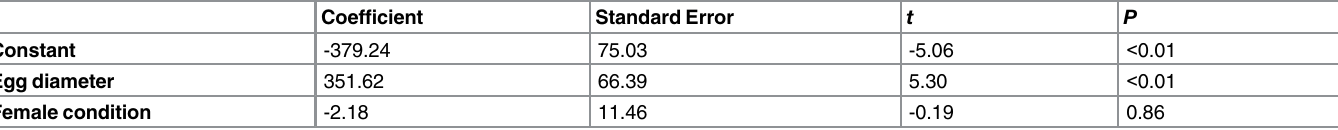
Table 3. Multiple linear regression analysis of the effect of egg diameter and female condition on survival in the embryo stage ( N = 8), multiple r 2 =